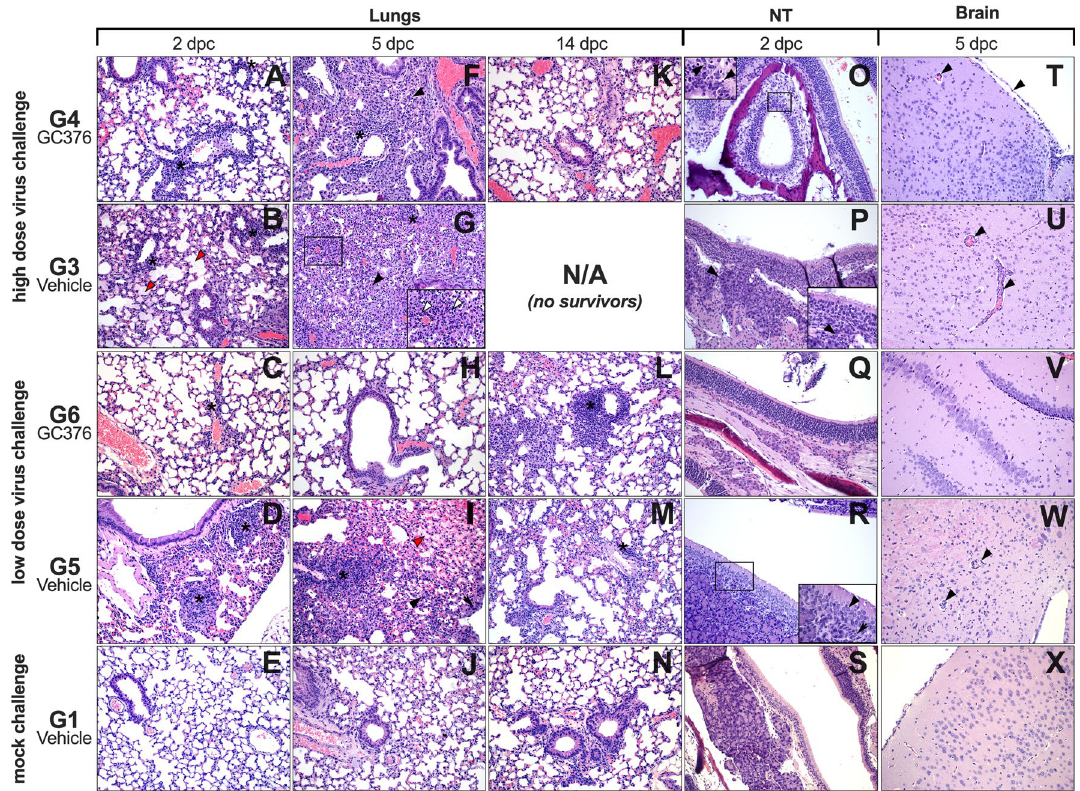
Figure 4. Microscopic findings in lungs, NT and brain from GC-376- and vehicle-treated mice at selected time points. ( A – D ) Mild to moderate incremental lymphoplasmacytic and histiocytic perivascular infiltrates were observed at 2 dpc in the lungs of all groups (asterisks). ( B ) G3, lungs at 2 dpc, alveolar spaces were also effaced by edema (red arrowheads). ( E ) G1, lungs at 2 dpc were normal. ( F , G , I ) Marked pulmonary consolidation was observed at 5 dpc in lungs from G4, G3 and G5 due to pneumocyte type II hyperplasia and marked interstitial inflammation (black arrowheads). Asterisks mark perivascular cuffs of mononuclear cells. ( G ) Marked neutrophilic inflammation was also observed (white arrowheads) in G3 lungs at 5 dpc ( I ) Moderate alveolar edema (red arrowhead) and pleuritis (black arrow), were present at 5 dpc in G5. ( H ) G6 lungs did not present any lesions in 2/3 mice at 5 dpc. ( J ) G1, normal lungs, 5 dpc. ( K – N ) Lungs at 14 dpc, presented from none to minimal perivascular and peri-bronchial lymphoplasmacytic and histiocytic infiltrates (asterisks). ( O , P , R ) Nasal turbinates presented minimal changes in G4, G3 and G5 at 2 dpc. ( O ) G4, NT, at 2 dpc; mild vacuolar degeneration, pyknosis, and karyorrhexis of single olfactory epithelial cells (arrowheads). ( P ) G3, NT, at 2 dpc; the lamina propria was mildly expanded by neutrophils, lymphocytes and macrophages (arrowheads). ( Q , S ) No lesions were observed in neither G6 nor G1 NT at 2 dpc. ( R ) G5, NT at 2 dpc; olfactory epithelium was attenuated and vacuolated (arrowhead), and the lamina propria expanded by small numbers of neutrophils and macrophages (black arrow). ( T – U , W ) Brain from G4, G3 and G5 mice at 5 dpc, presented mild to moderate multifocal lymphoplasmacytic perivascular cuffing (arrowheads) surrounded by mild areas of hypercellularity (gliosis). ( V , X ) No lesions were observed in G6 and G1, at 5 dpc. Pictures and inserts were taken at 20 × and at 40 × magnification,